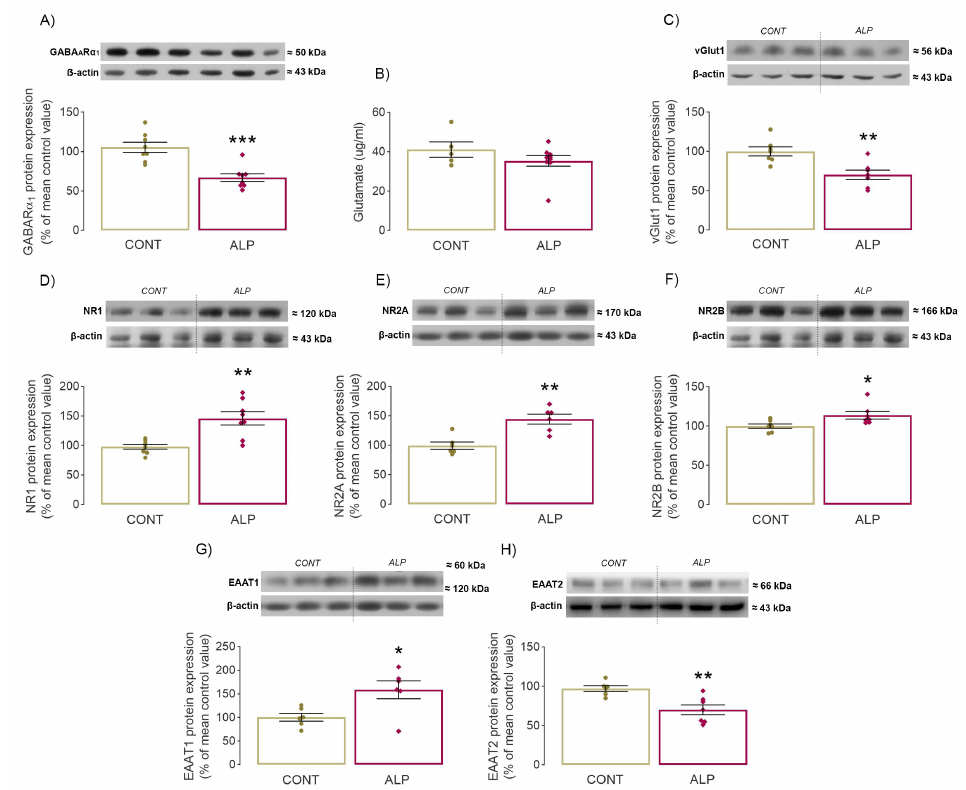
Figure 3. Effect of prolonged 14 days ALP treatment on hippocampal GABA A Rα1 protein expres- sion and components of glutamatergic signaling in vivo. ( A ) Representative immunoblot and quan- titative data of Western blot analysis of GABA A Rα1 protein expression, ( B ) g lutamate level in hip- pocampal P2 fraction (µg/mL), ( C – H ) r epresentative immunoblots and quantitative data of Western blot analysis of target proteins expression in hippocampal P2 fraction: ( C ) vGlut1, ( D ) NR1, ( E ) NR2A, ( F ) NR2B, ( G ) EAAT1, ( H ) EAAT2. Data were statistically analyzed by two-tailed t -test and expressed as percentage of the mean values of CONT group ± SEM (dots in the graphs represent values of individual animals). Symbols indicate significant differences between CONT and ALP group: * p < 0.05, ** p < 0.01, *** p < 0.001; animals per group: 8.